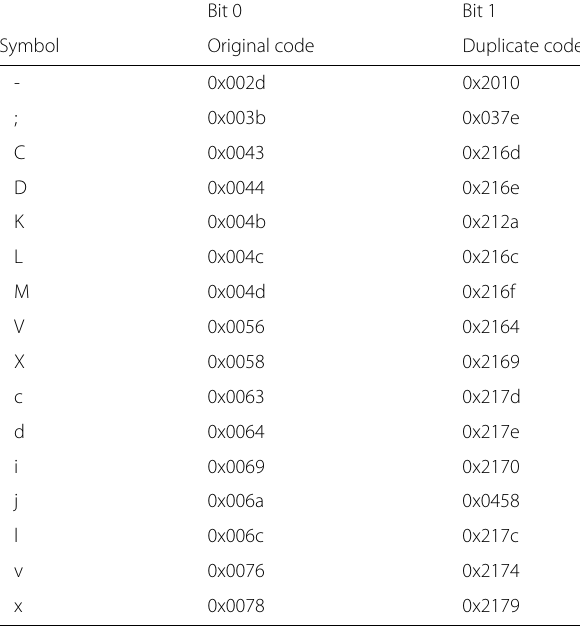
Subset of confusable symbols used to encode the watermark. Original and duplicate code is shown for each